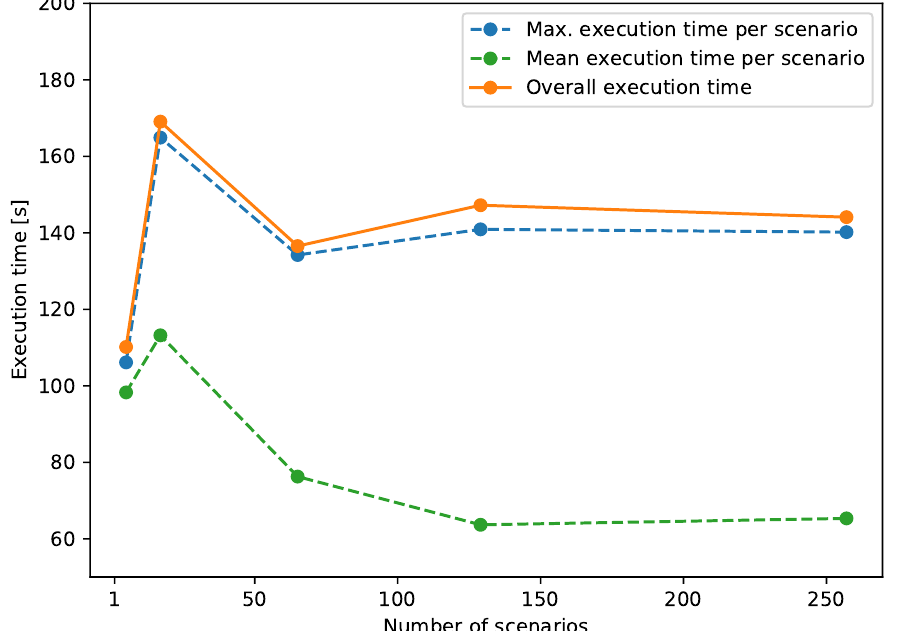
Figure 10. Test case 3 execution time of a parallel simulation with an increasing number of